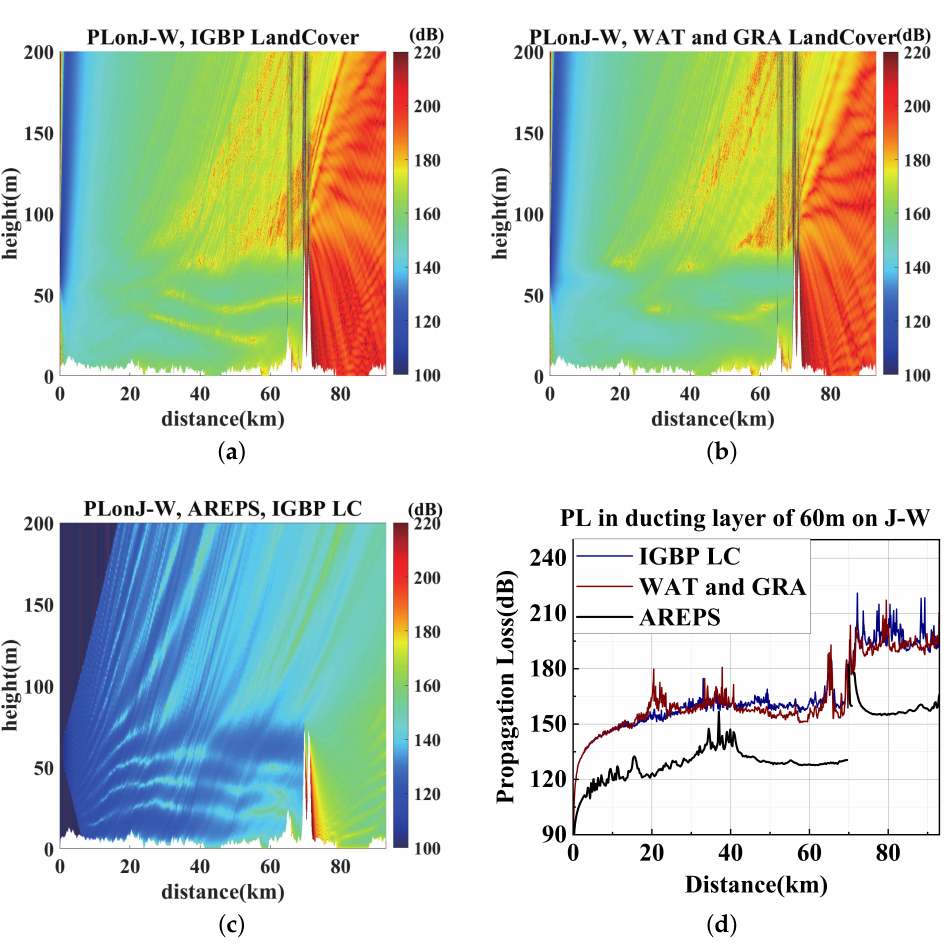
Figure 18. The Propagation loss with tropospheric scattering, IGBP LC, and DEM on Jiaxing–Wuxi. ( a ) PL from Jiaxing–Wuxi using TPWE and IGBP LC. ( b ) PL from Jiaxing–Wuxi using TPWE, WAT, and GRA LC. ( c ) PL from Jiaxing–Wuxi using AREPS and IGBP LC. ( d ) PL at the duct-trapping layer of 60 m of different